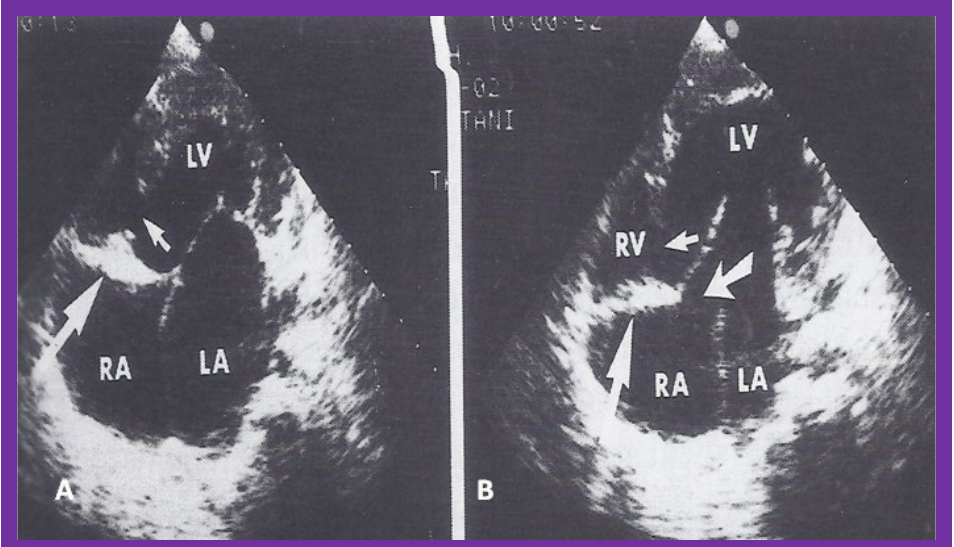
Figure 5. Apical four chamber view pictures of an infant with tricuspid atresia with ostium primum atrial septal defect (large arrow in the middle of ( B )). Note the small right ventricle (RV) and a ventricular septal defect (small arrow in ( A , B )). LA, left atrium; LV, left ventricle; RA, right atrium. Reproduced from Reference [28].